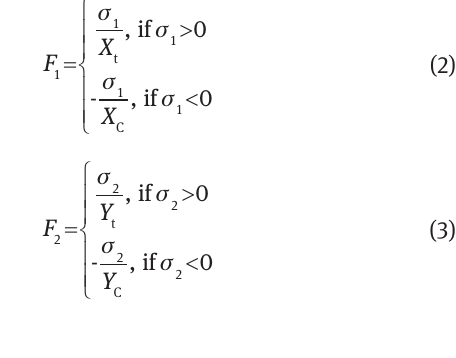
Figure 10: Distribution of the first failure factor in [0]